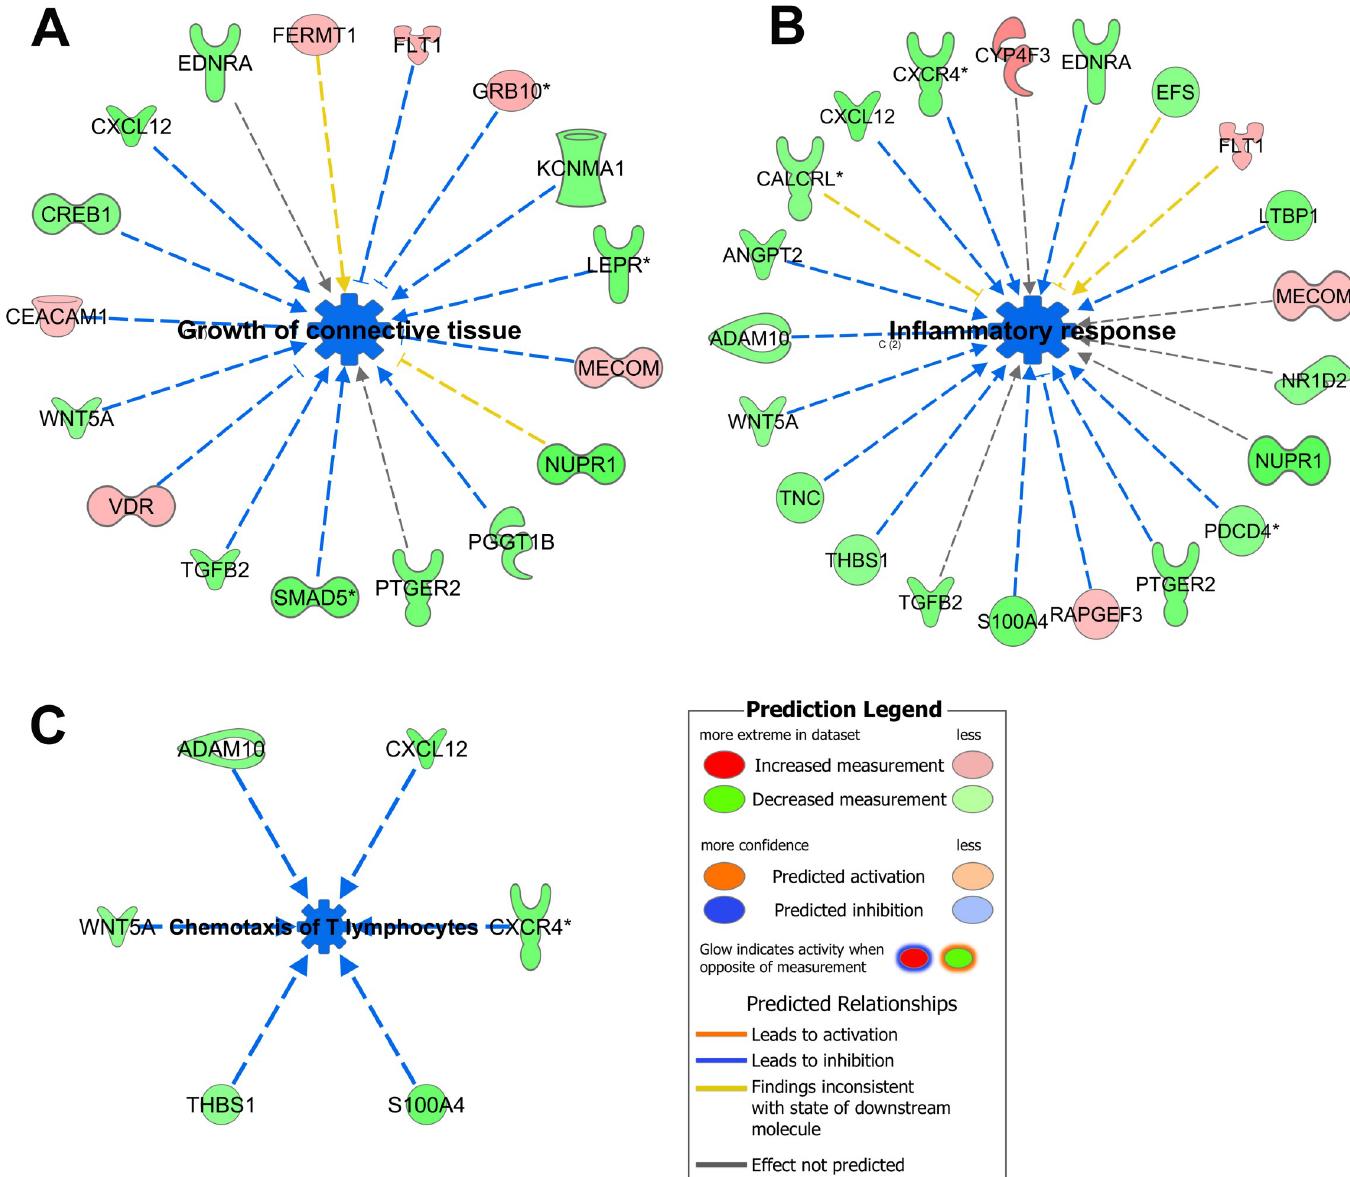
Fig 6. Inhibition of major functions. Functions like growth of connective tissue ( A ), inflammatory response (B ), and chemotaxis of T lymphocytes ( C ) were predicted to be inhibited (blue) and the genes involved were mostly downregulated (green). The legend with the color code for the prediction is shown at the bottom right. Please see Table G in S5 File for complete